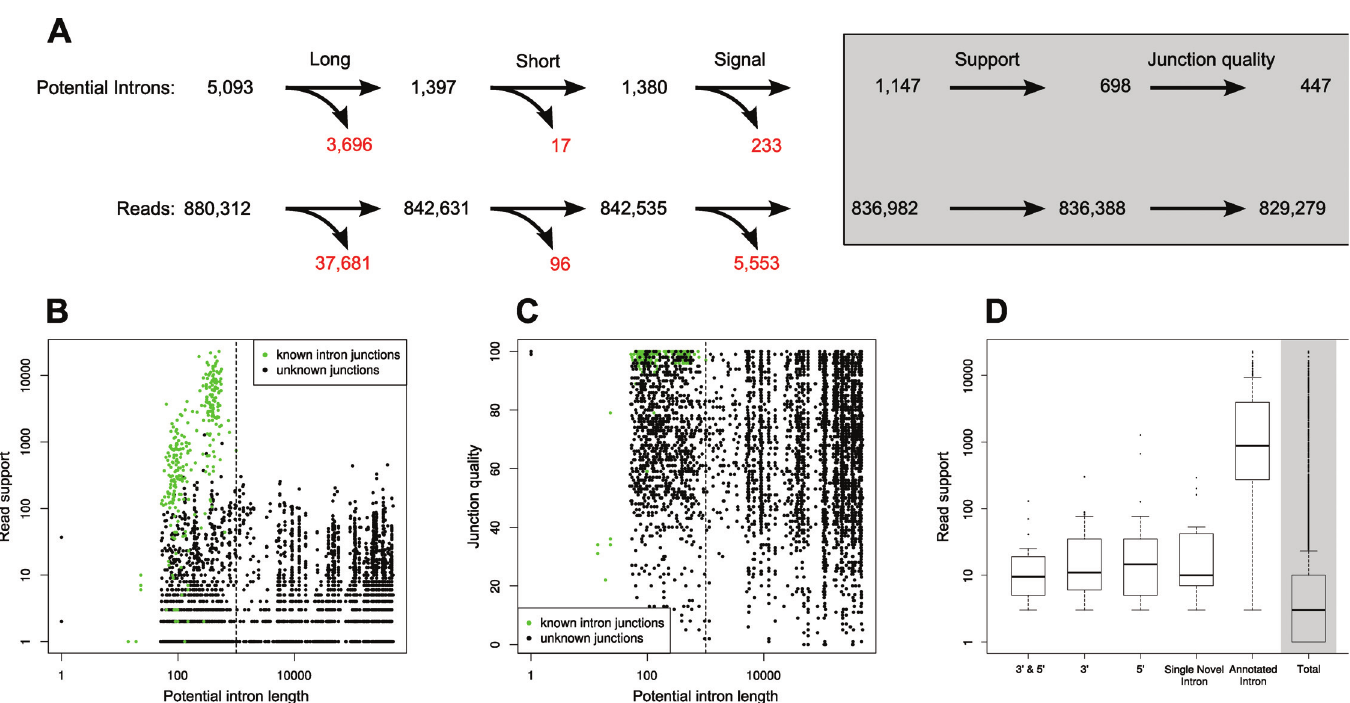
Fig 2. (A) Classification and filtering of reads and potential introns for further analysis. Long: the potential intron is longer than 1002 bases. Short: it is shorter than 40 bases. Signal: the potential intron is not flanked by a canonical splice signal. Support: the potential intron is supported by only one or two reads. After applying all filters, 94.2% of all reads (corresponding to 8.8% of all potential introns) pass this pipeline. (B) Read support for potential and annotated introns. The dashed line marks the longest known intron in S. cerevisiae. The high read support for annotated introns is clearly visible. There are cases of unknown potential introns with comparable read support, possibly representing novel introns. Evidence of longer introns (right of the dashed line) is not as strong, distinguishing them clearly from known introns. The two length classes of introns are visible, clustering around length 100 and 400. (C) Junction quality reports how well an intron junction is defined by split reads. Values close to 100 indicate long regions before and after the junction that are supported by split reads (anchor), lower values indicate shorter regions. Values also become lower if the exact split is not clearly defined, i.e. it would also map n bases upstream or downstream. For details refer to the methods section. (D) The distribution of read support for all unfiltered potential introns (total, grey background) is skewed with a median of 3 and an average of 171.1 reads. Read support for unfiltered potential introns is compared to that of filtered ones (white background): the highest read support is found among annotated introns in protein coding genes (Annotated Introns) with a median of 787 and mean of 2843.0 reads. Different classes of alternative splicing (3 ’ , 5 ’ , both alternative splice sites, single introns) exhibit different read support, with the lowest median (13) for combined 3 ’ & 5 ’ (both) alternative splice site